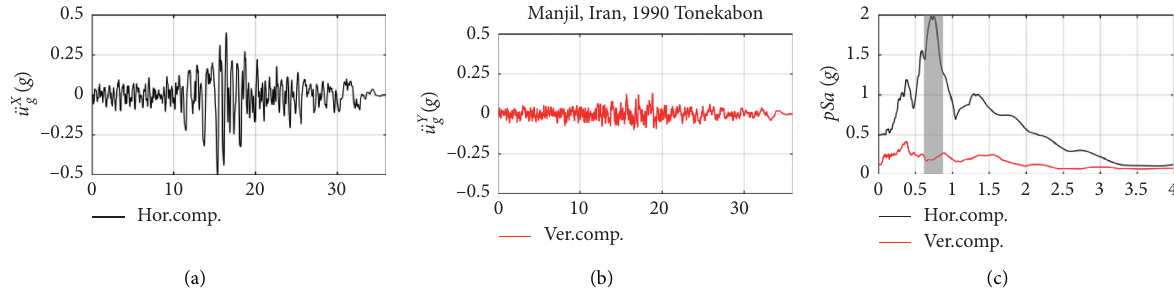
Figure 12: 1990 Manjil earthquake recorded at Tonekabon station: (a) horizontal component, (b) vertical component, and (c) the pseudoacceleration spectra where ranges of period with higher horizontal spectral power are shown in